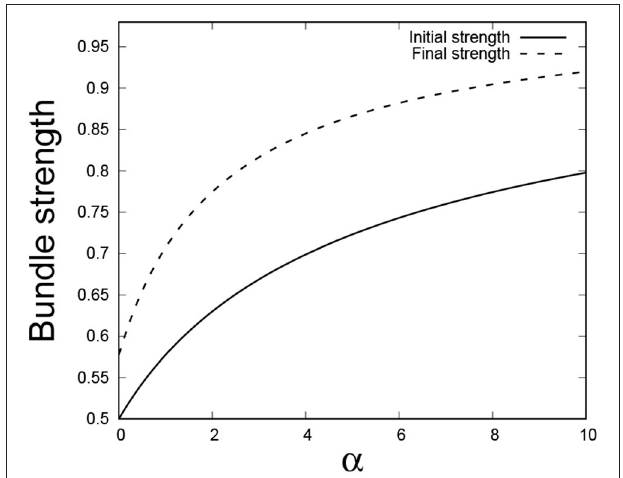
FIGURE 13 | Initial and final strengths of the fiber bundle vs. power law index ( α ) under both the order space and the real space renormalization group schemes. For α 0, the distribution is reduced to the uniform distribution and = the initial and final strength values match well with our numerical